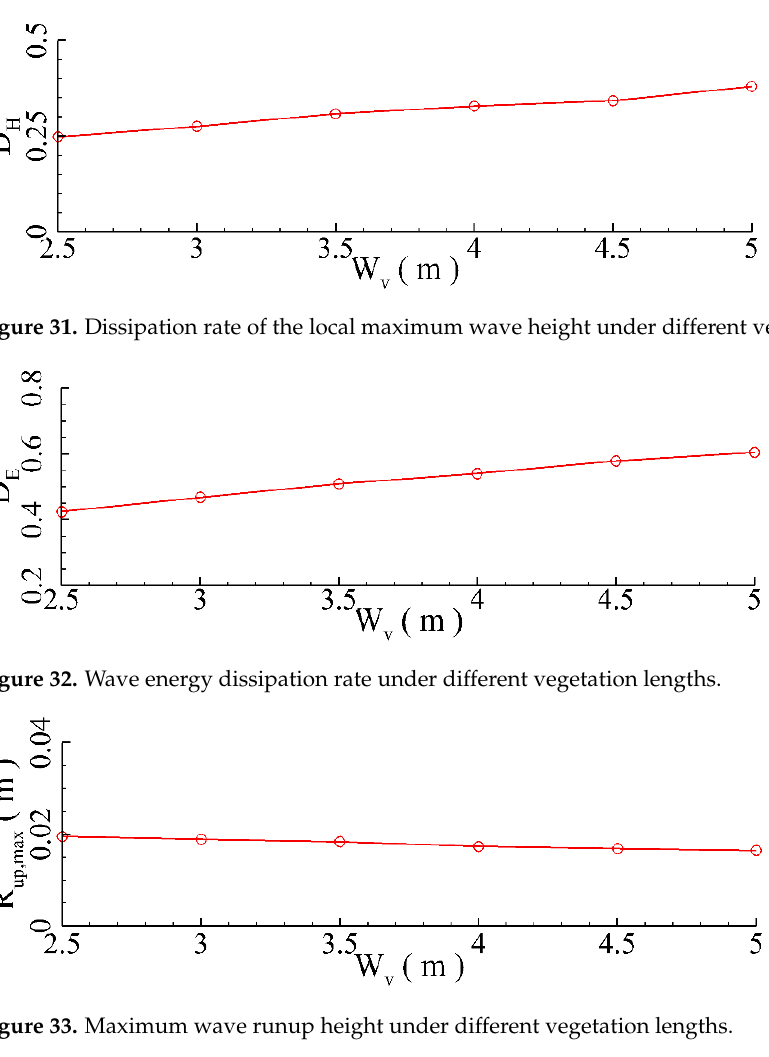
Figure 33. Maximum wave runup height under different vegetation lengths.